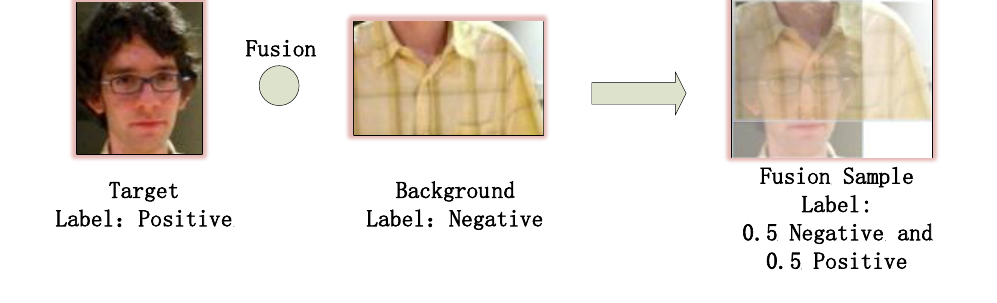
Figure 2. Training sample fusion when λ = 0.5. Algorithm 1 Training Sample